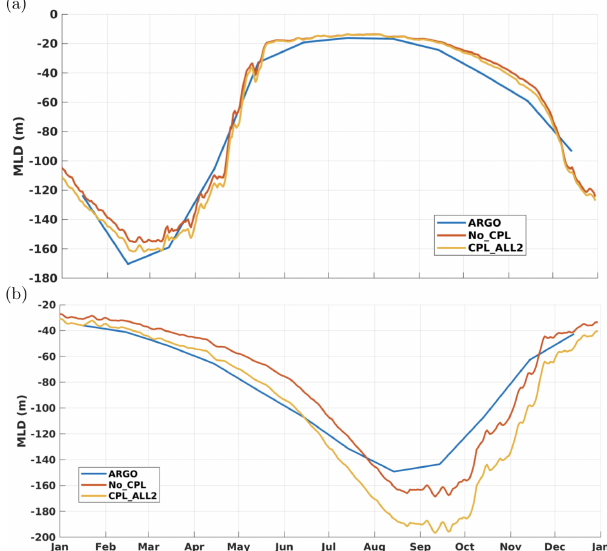
Figure 9. Spatially averaged MLD for (a) the Northern Hemisphere and (b) the Southern